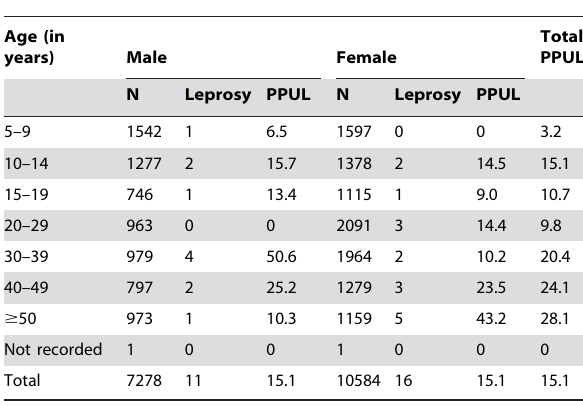
Table 2. Number of people examined and prevalence of previously undiagnosed leprosy (PPUL) per 10,000 by age and